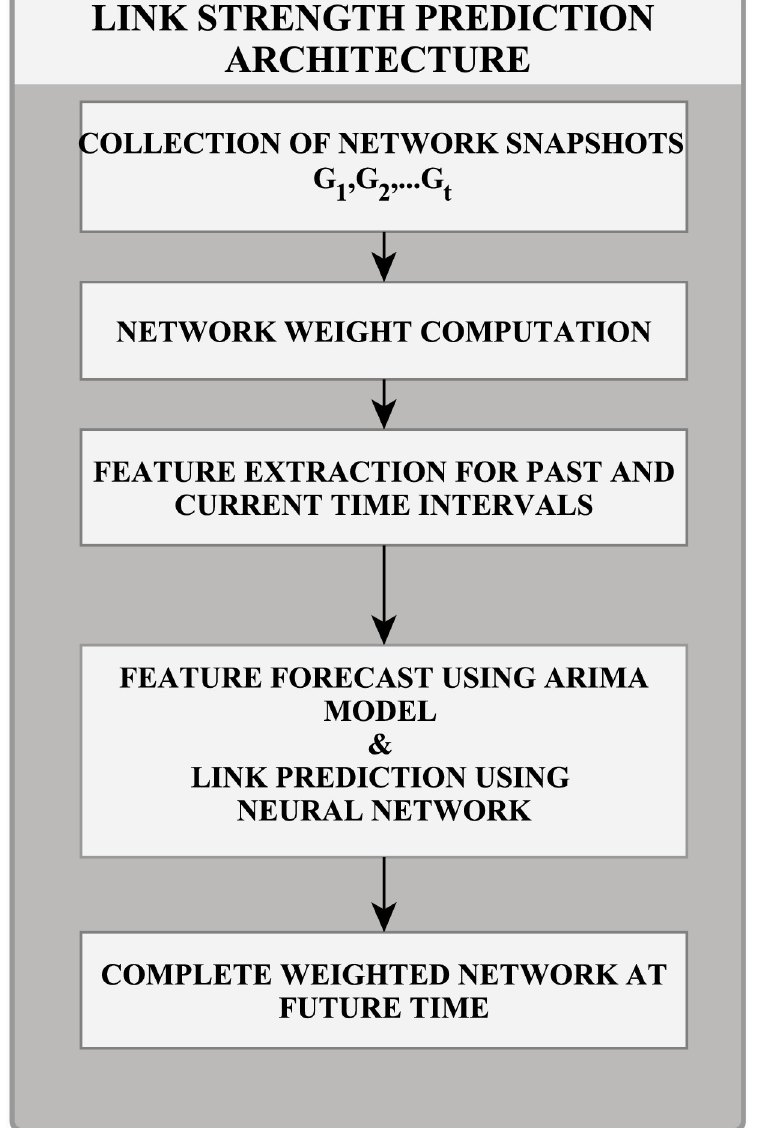
Fig 2. Architectural